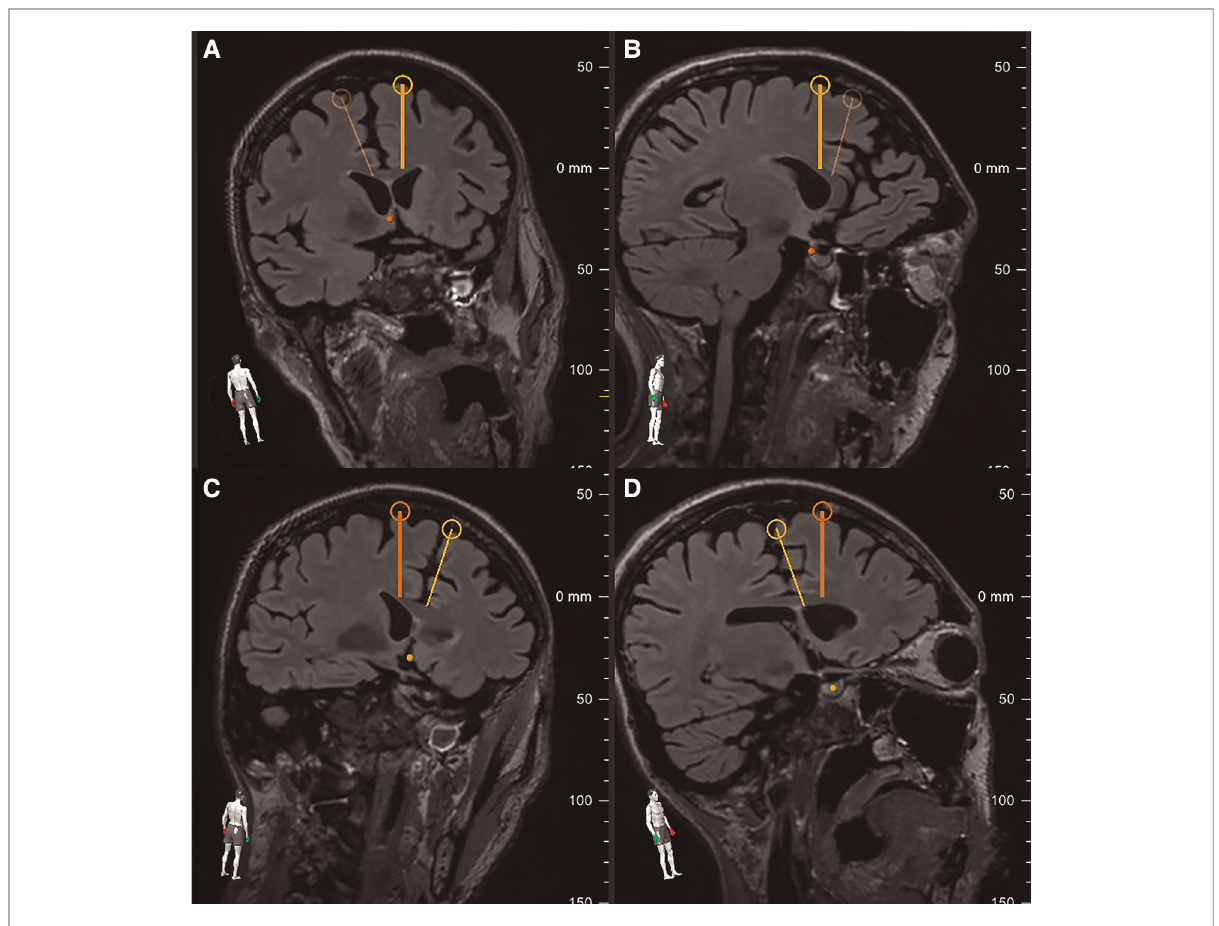
FIGURE 2 The pre-operative planning software allowed for rotational veri fi cation of the right ( A,B – bold yellow line) and left ( C,D – bold orange line) trajectories. Note each trajectory ’ s proximity to the white matter tracts intended for ablation while avoiding the associated subcortical U- fi bers.